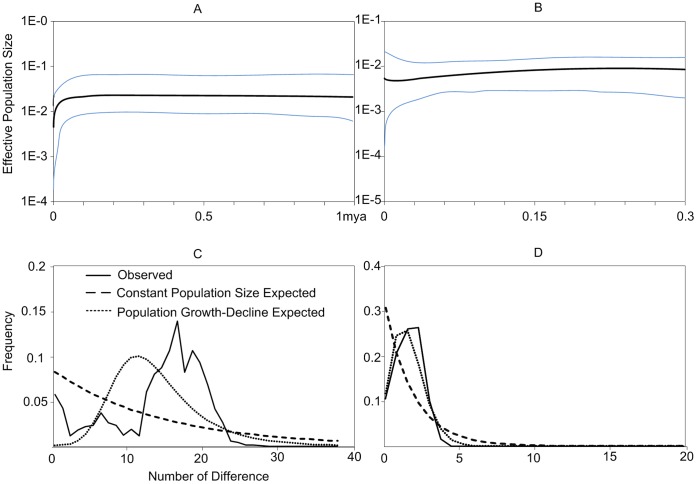
Bayesian skyline plot of past demographic trends and mismatch distributions based on haplotypes of T. francoisi (A and C) and T. leucocephalus (B and D).In a) and b), x-axis represents time in mya; y-axis represents estimated population size (units = Neτ, the product of effective population size and generation time in years, log-transformed). The mean estimate and the 95% HPD limits are indicated as black and blue lines, respectively. In c) and d), the frequencies of pairwise differences haplotypes are shown.